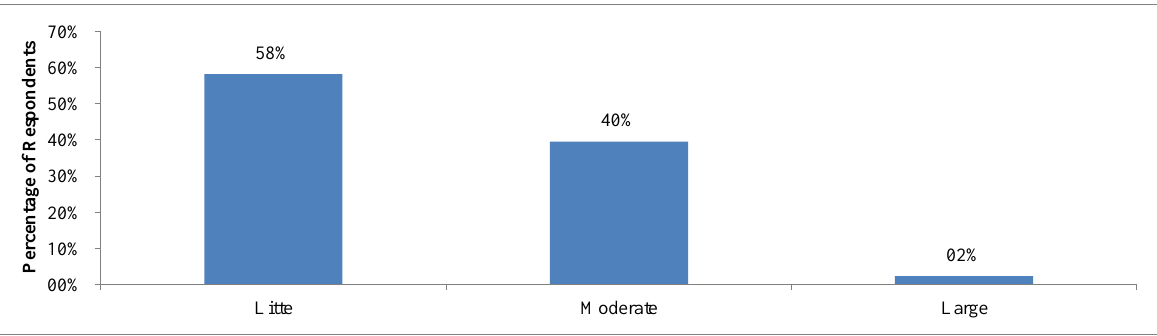
Figure 4: Respondents view on Improvement in Quality of